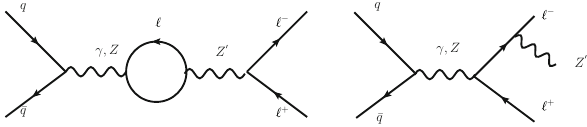
Fig. 3 Feynman diagrams for the Drell–Yan process induced by Z (cid:2) (left panel) and associated production process Z (cid:2) (cid:2) + (cid:2) − (right panel) at the LHC